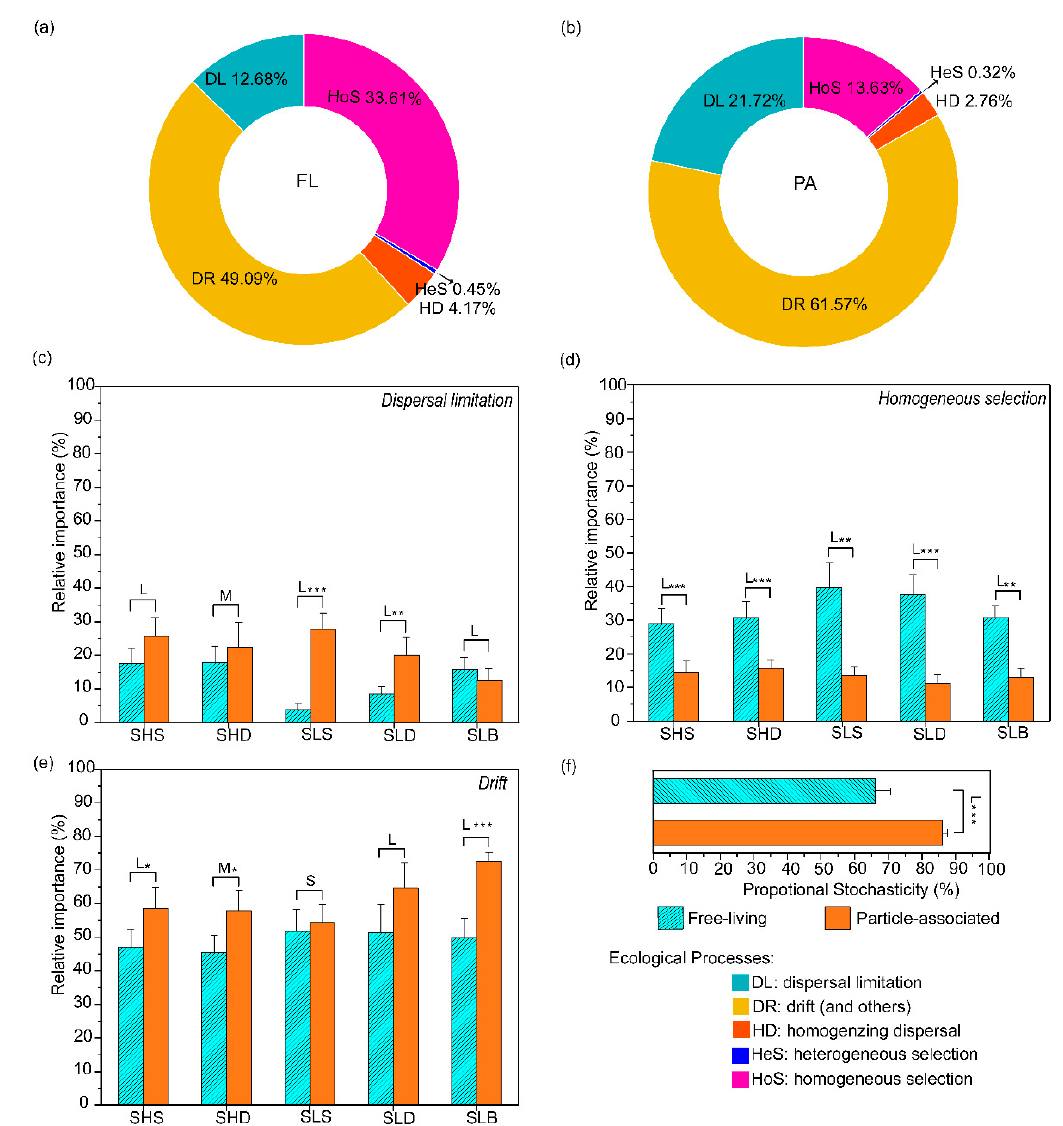
Figure 7. Doughnut and bar plots displaying the relative influences of assembly processes governing community turnover. ( a ) free-living community. ( b ) particle-associated community. ( c ) Changes of homogeneous selection under particle associated (orange bar) and free living (aqua bar). ( d ) Changes of dispersal limitation. ( e ) Changes of drift. ( f ) Stochasticity estimated by iCAMP under particle associated (orange bar) and free living (aqua bar). One-side significance based on bootstrapping test was expressed as *** p < 0.01; ** p < 0.05; * p < 0.1. p = 0.0061, 0.0000, 0.0139, 0.0000, 0.0000 in 5 different groups for homogeneous selection; p = 0.1129, 0.2884, 0.0000, 0.0330, 0.2595 for dispersal limitaton; p = 0.0962, 0.0706, 0.3861, 0.1067, 0.0000 for drift, respectively. L, M, S and N represented large (|d| > 0.8), medium (0.5 < |d| ≤ 0.8), small (0.2 < |d| ≤ 0.5) and negligible (|d| ≤ 0.2) effect sizes of size-fraction, based on Cohen’s d (the mean difference between particle associated and free living divided by pooled standard deviation). Data are presented as mean values ± SD. Error bars represented standard deviations. ( c , d , f ) n ≥ 3 biologically independent samples at each group.